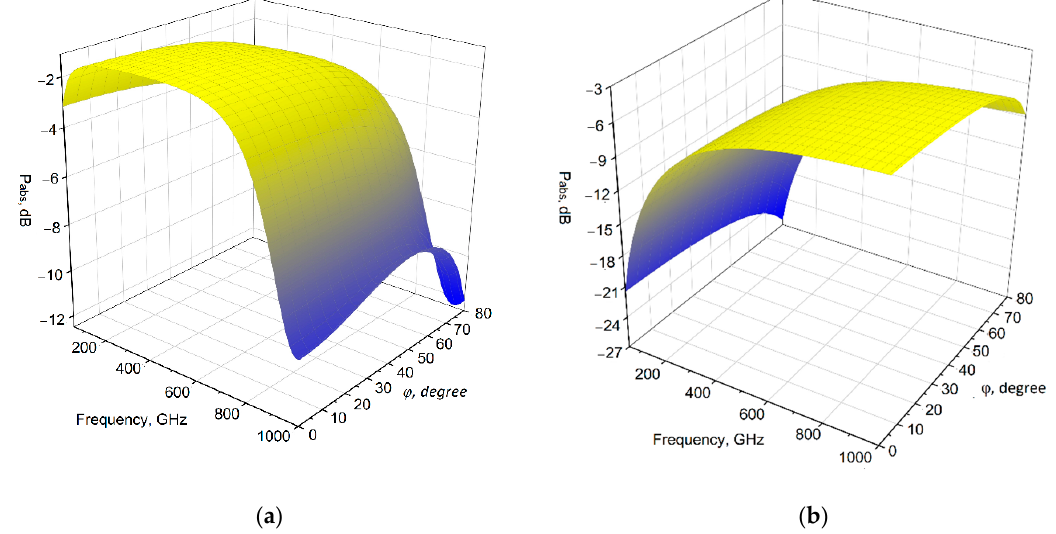
Figure 3. Computed Pabs for the FSS unit cell: ( a ) mode #1, ( b ) mode #2.